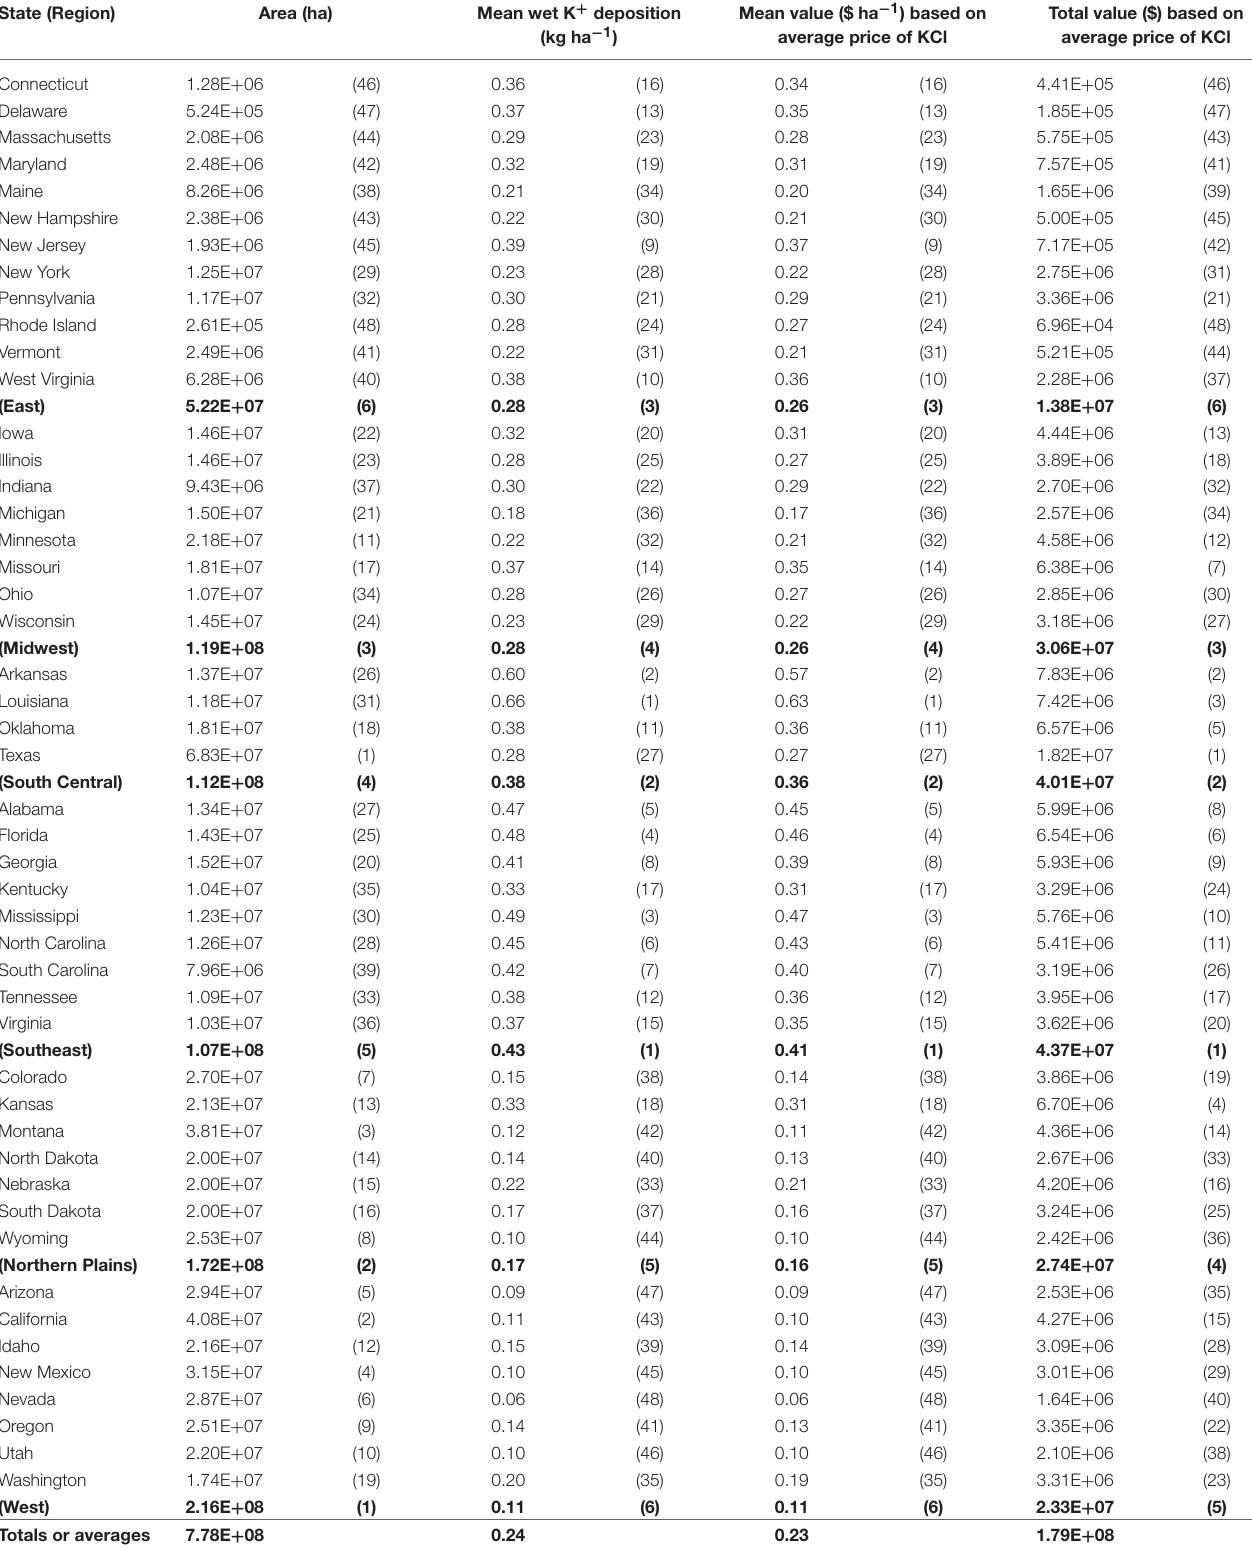
Bold type indicates regions consisting of the states listed immediately